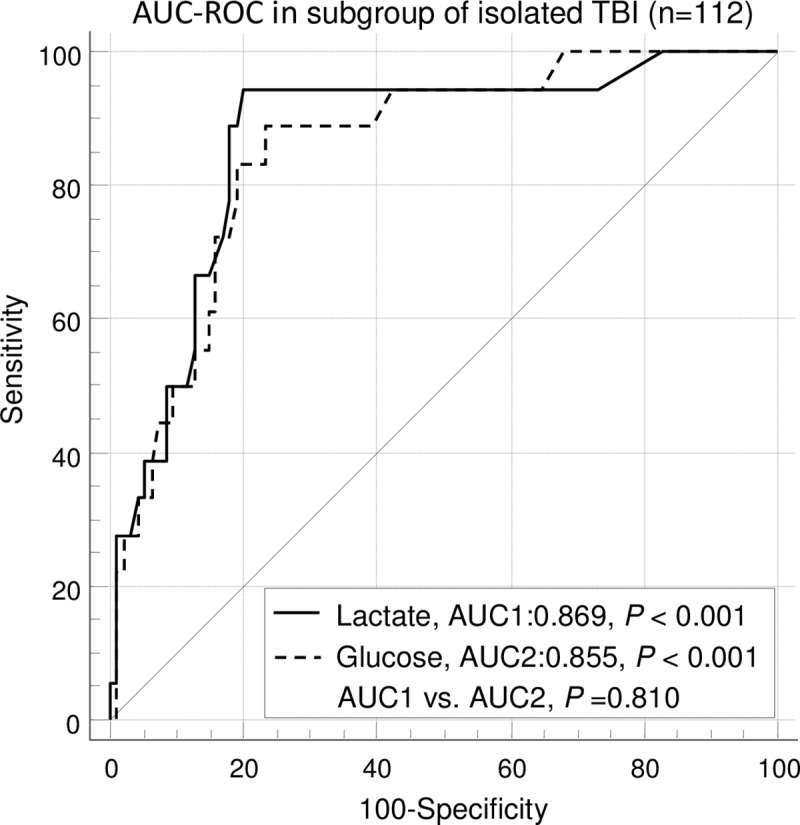
ROC curve analyses of mortality in subgroup of isolated TBI.The AUC of admission lactate was not significantly different from the AUC of admission glucose. AUC- area under the curve; GCS- glasgow coma scale; ROC- receiver operating characteristic.